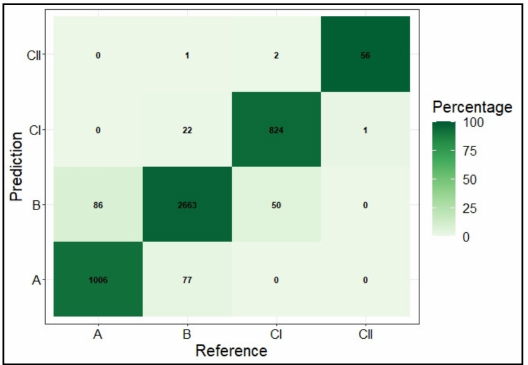
Figure 11. Confusion matrix of the classification performance of the ERT model.